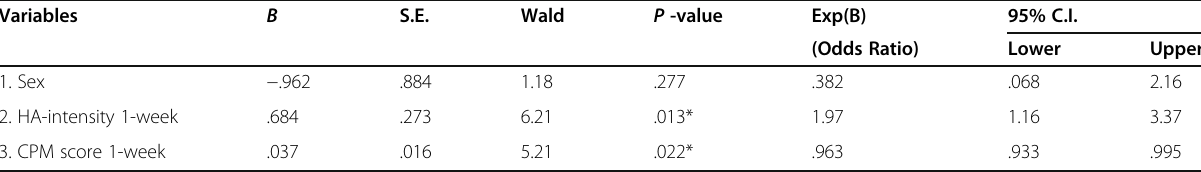
Table 3 Summary of multiple logistic regression results for prediction of PPTH at 4-months post-mild TBI Variables